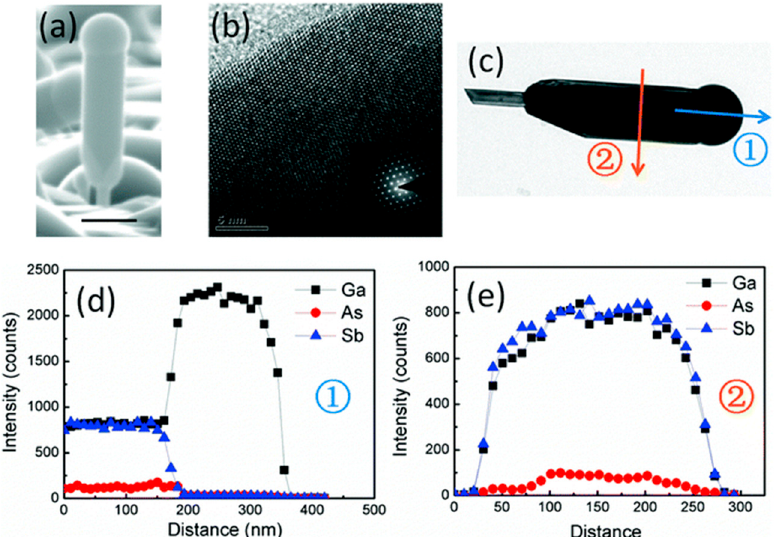
Figure 14. ( a ) A typical SEM image of the GaSb section ( b ) High resolution TEM of a GaSb nanowire (NW). The inset is the SAED image from the same GaSb NW. ( c ) TEM image of a GaSb section showing the directions of EDX line scans. ( d , e ) are the corresponding EDX line scans along the axial and cross-axial directions, respectively. Reproduced with permission from [81], copyright RSC Pub (2016).